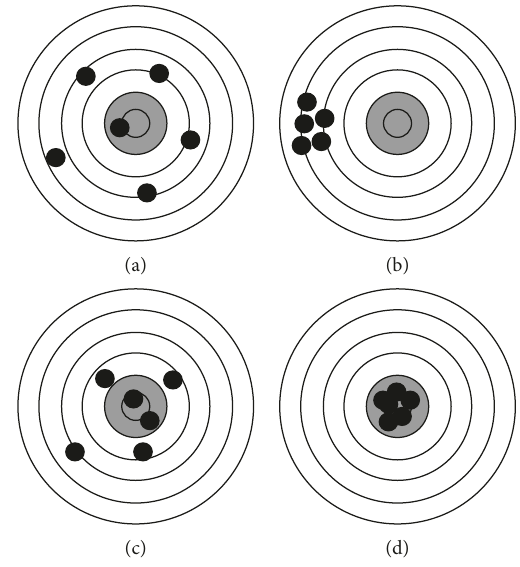
Figure 1: Illustration of the correlation between accuracy and precision. (a) Low accuracy, low precision. (b) Low accuracy, high precision. (c) High accuracy, low precision. (d) High accuracy, high